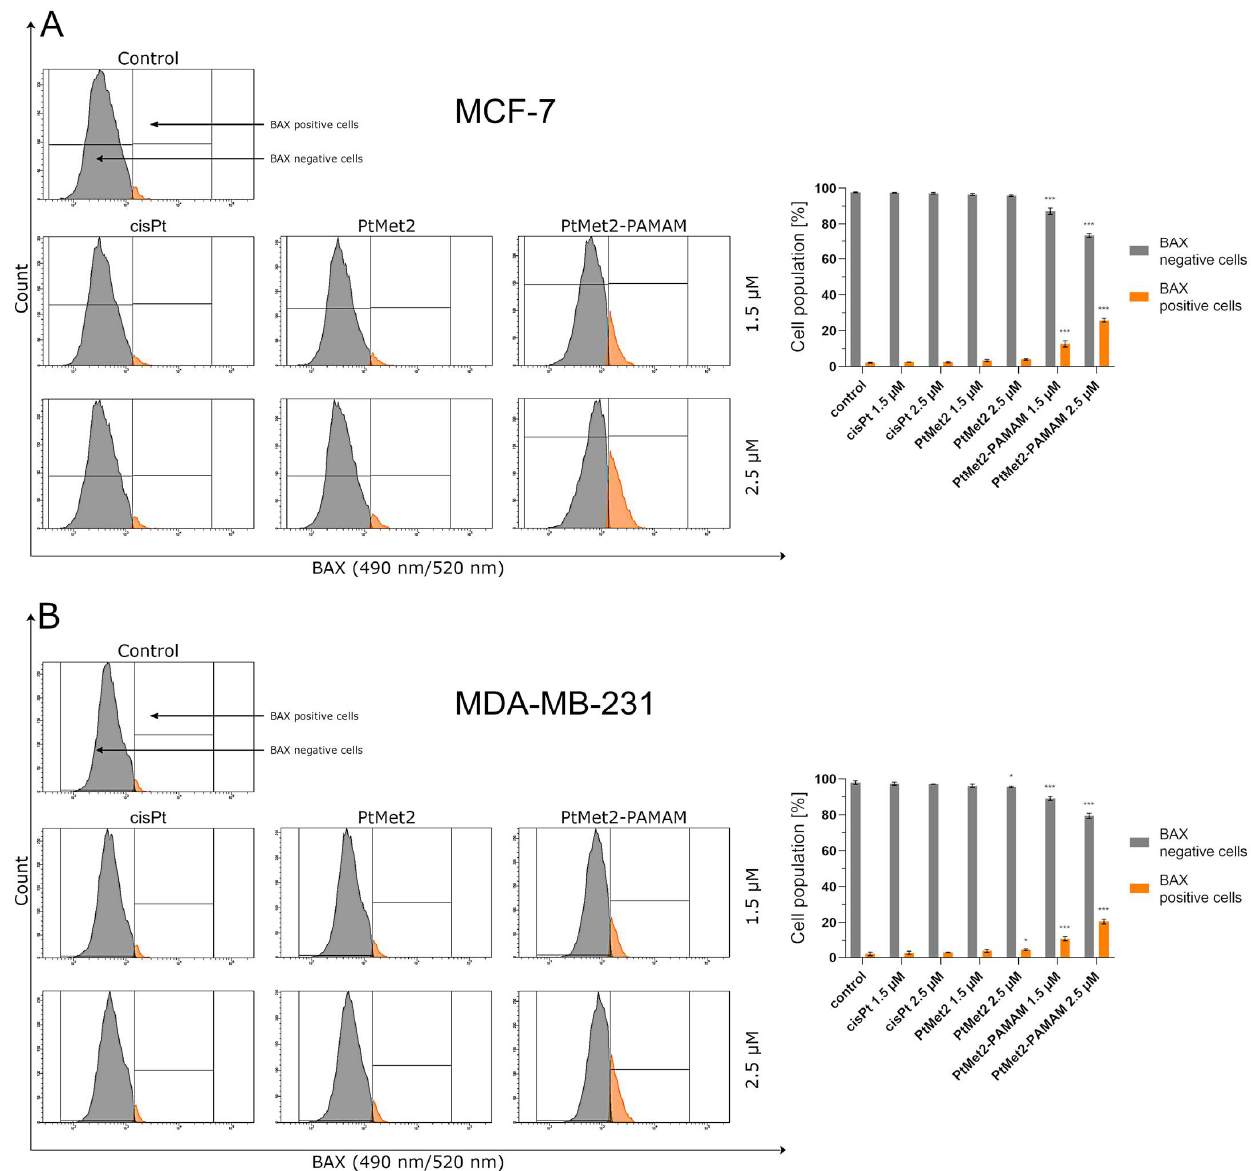
Figure 7. Anti-Bax antibody flow cytometric analysis of MCF-7 ( A ) and MDA-MB-231 ( B ) breast cancer cells (orange color) compared to a negative control cell (gray color) after 24 h of incubation with PtMet2, PtMet2–PAMAM, and cisplatin (1.5 and 2.5 μM). Mean percentage values from three independent experiments ( n = 3) done in duplicate are presented. * p < 0.05 vs. control group, *** p < 0.001 vs. control group.